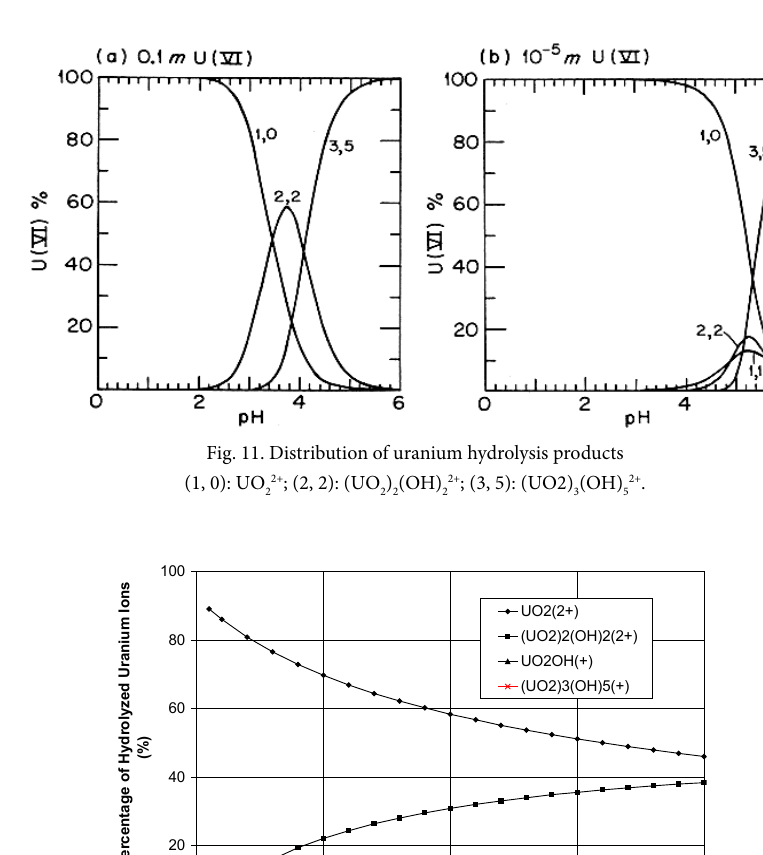
Fig. 12 . Fig. 12. Ionic composition of hydrolyzed uranium ions at pH